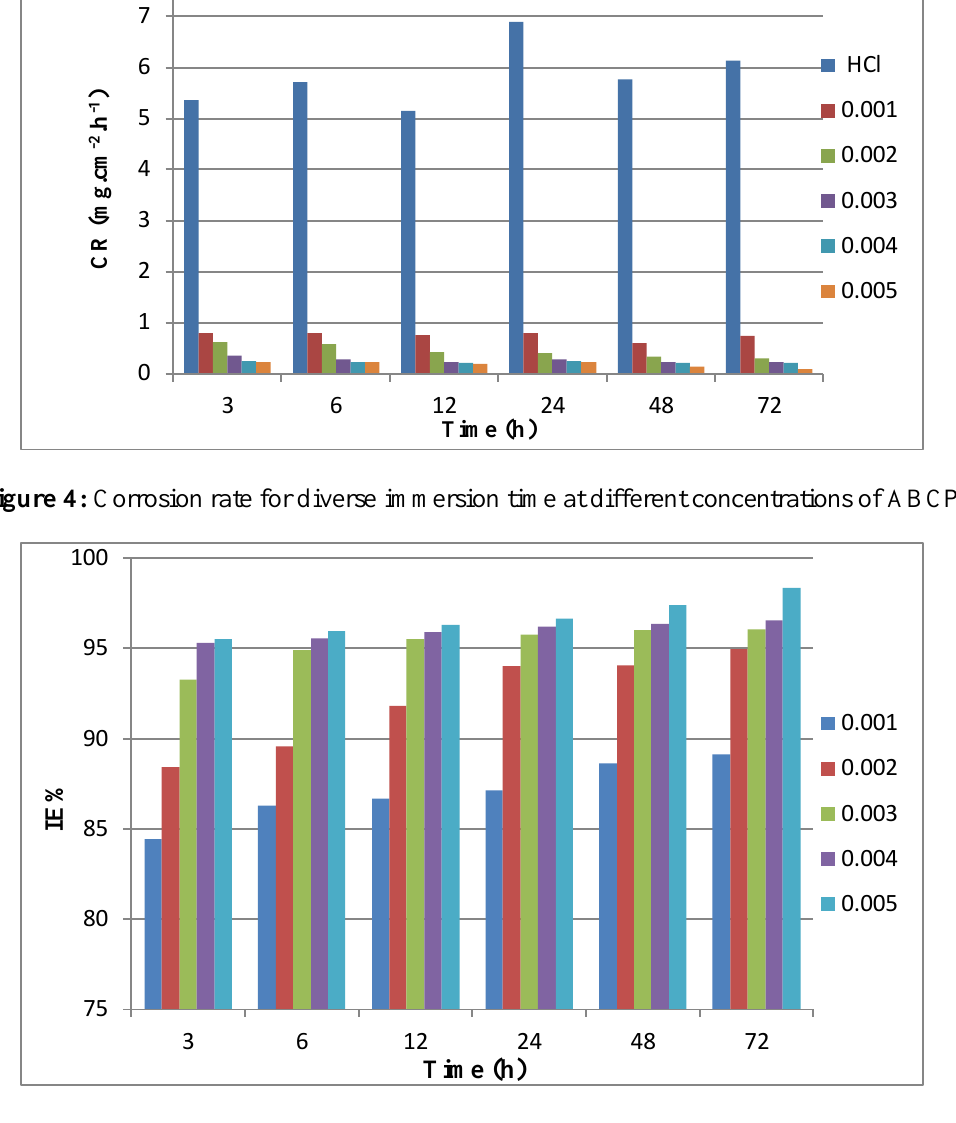
Figure 5: Inhibition Efficiency of different ABCP concentrations at different times of